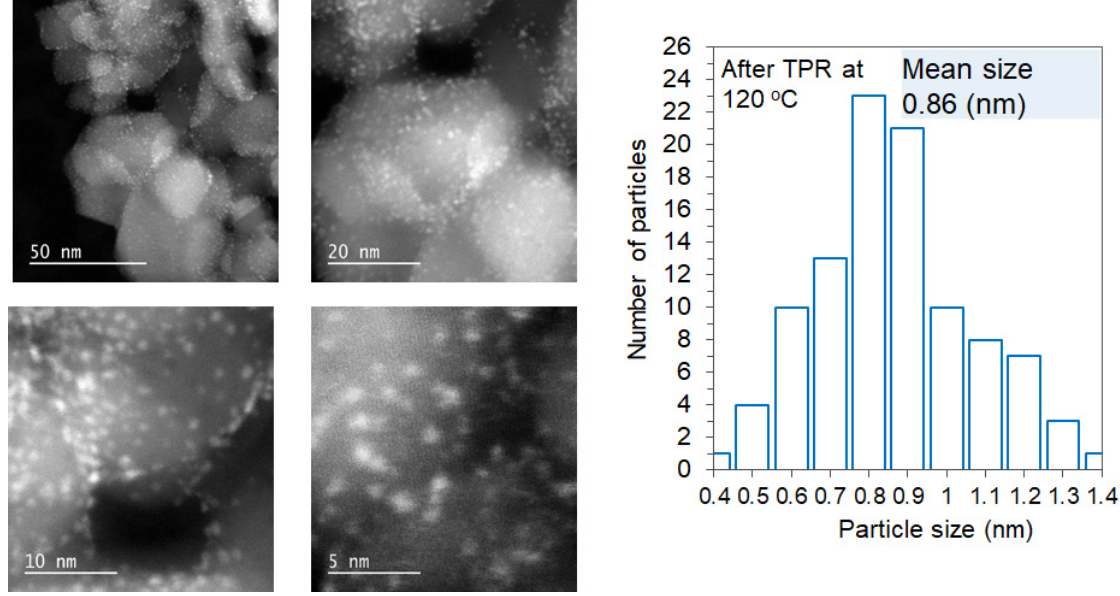
Figure 6. TEM images and extracted mean particle size of 3.5 wt.% IrO 2 /TiO 2 (anatase, BET surface area = 55 m 2 /g) that has been reduced during TPR up to 120 °C, at different magnifications. Standard errors (0.02 nm).